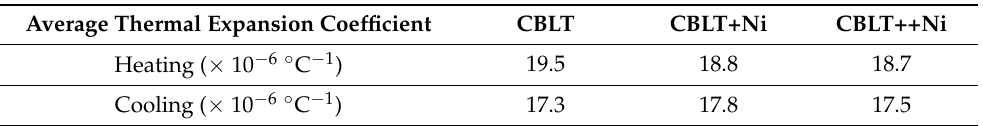
Figure 4. The isothermal parts of the TMA curves (plotted in the (deformation versus time) scheme): ( A ) the CBLT alloy; ( B ) the CBLT+Ni alloy; ( C ) the CBLT++Ni alloy. Table 3. The average coefficients of thermal expansion (heating) or contraction (cooling) over the (25–1250 ◦ C) temperature